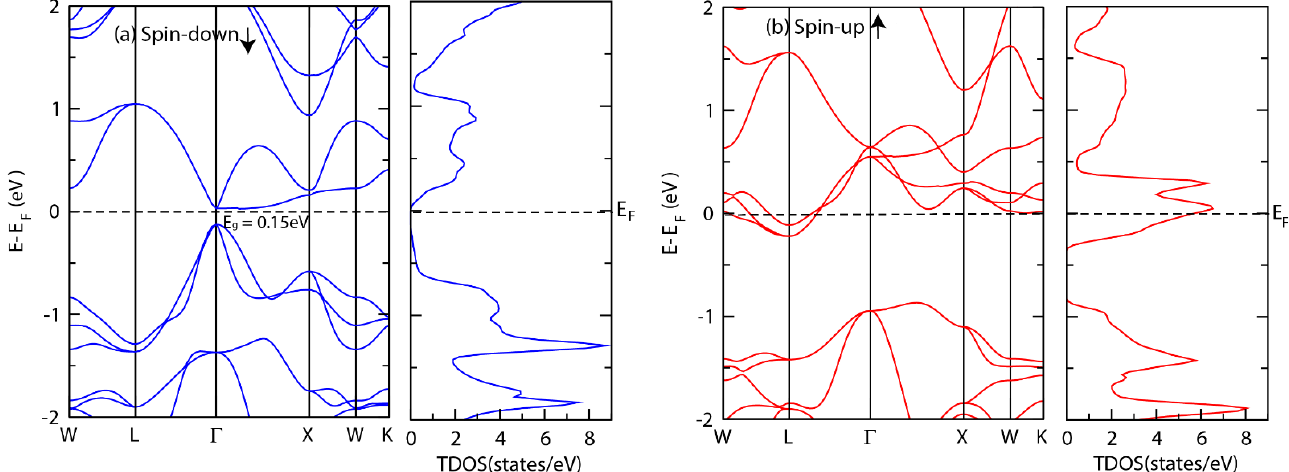
Figure 3. Electronic band structure and total density of states (TDOS) of CrTiCoAl in ( a ) the spin up channel and ( b ) the spin down channel.